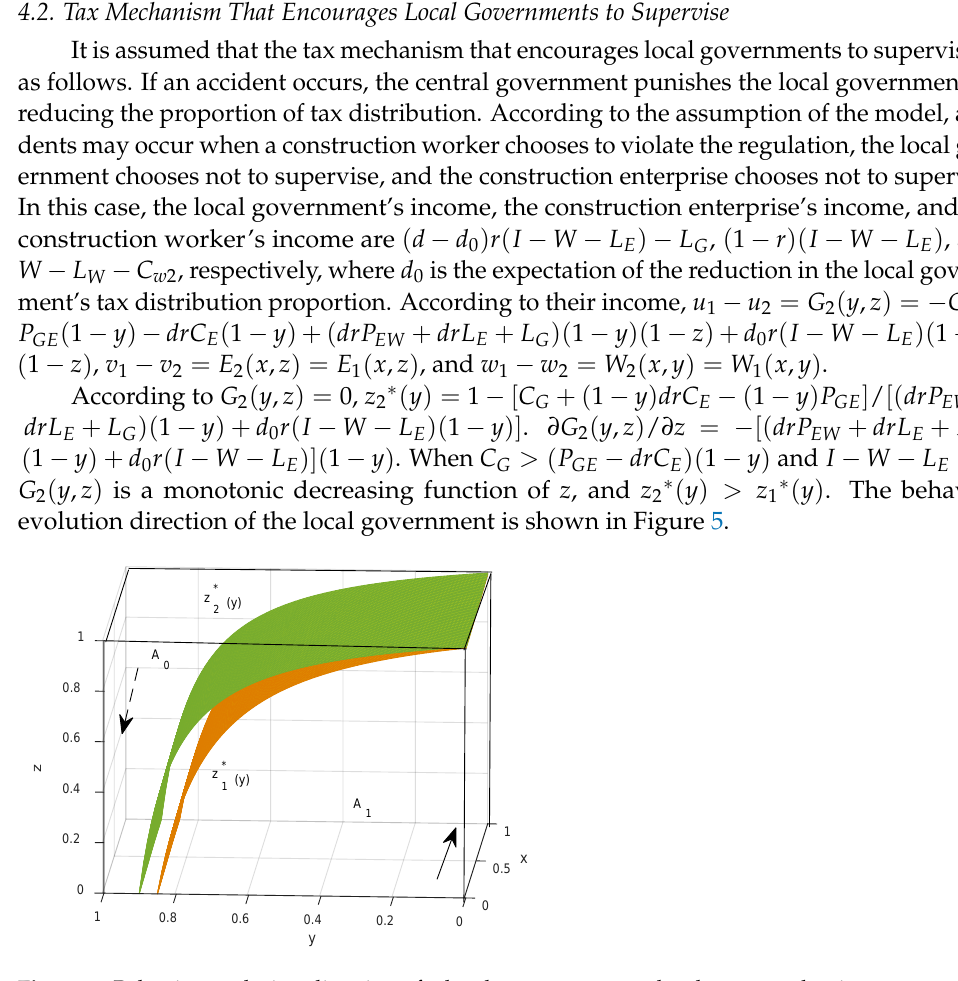
Figure 5. Behavior evolution direction of a local government under the tax mechanism.